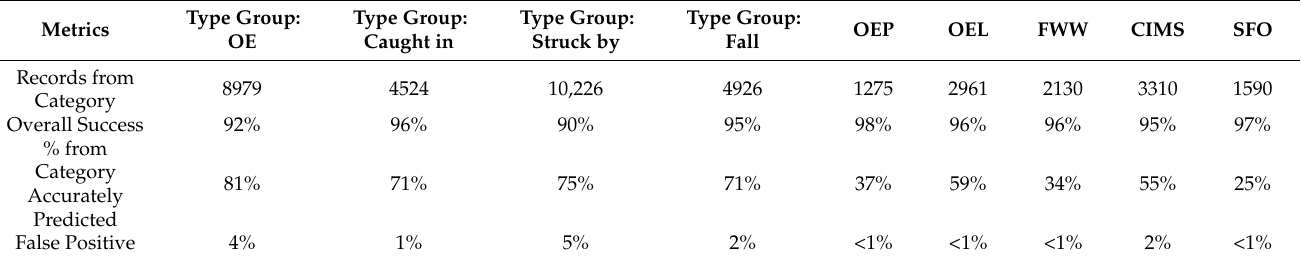
Table 3. Results of RF models in the MSHA test